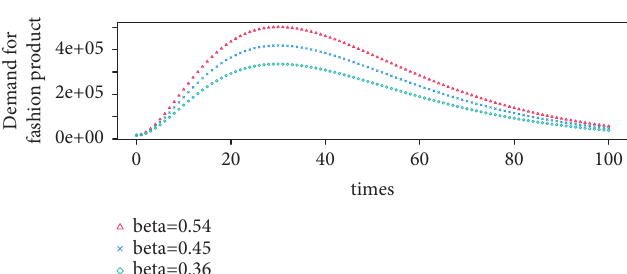
Figure 14: Simulation of the demand for fashion products at different values of the disease threshold I regulation declines, and the demand for fashion products increases.